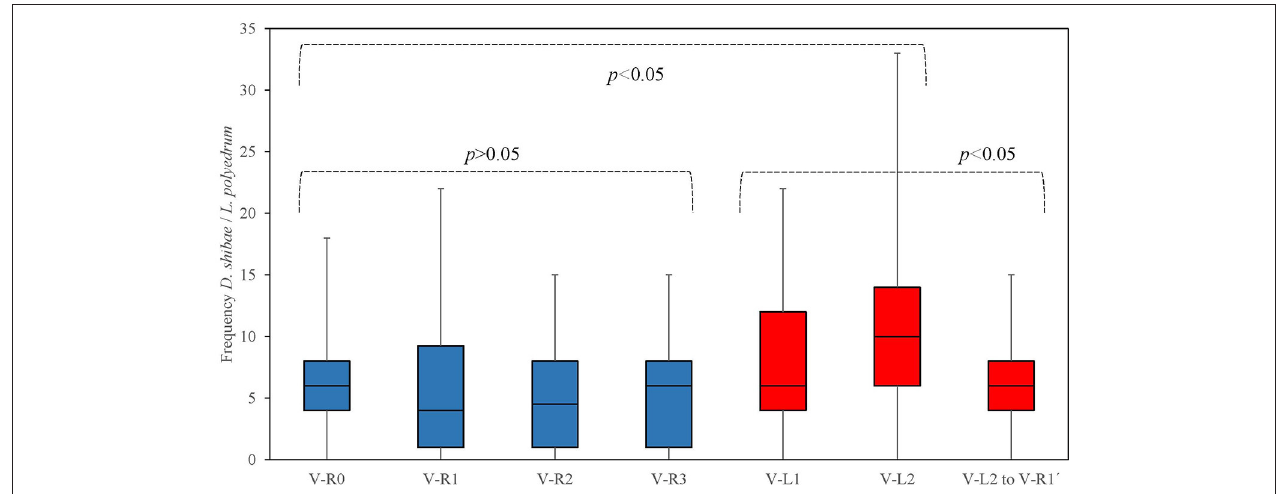
FIGURE 2 | Frequency of D. shibae cells attached to single L. polyedrum cell in semi-continuous culture conditions. L. polyedrum in V-R culture ( ), and V-L culture (